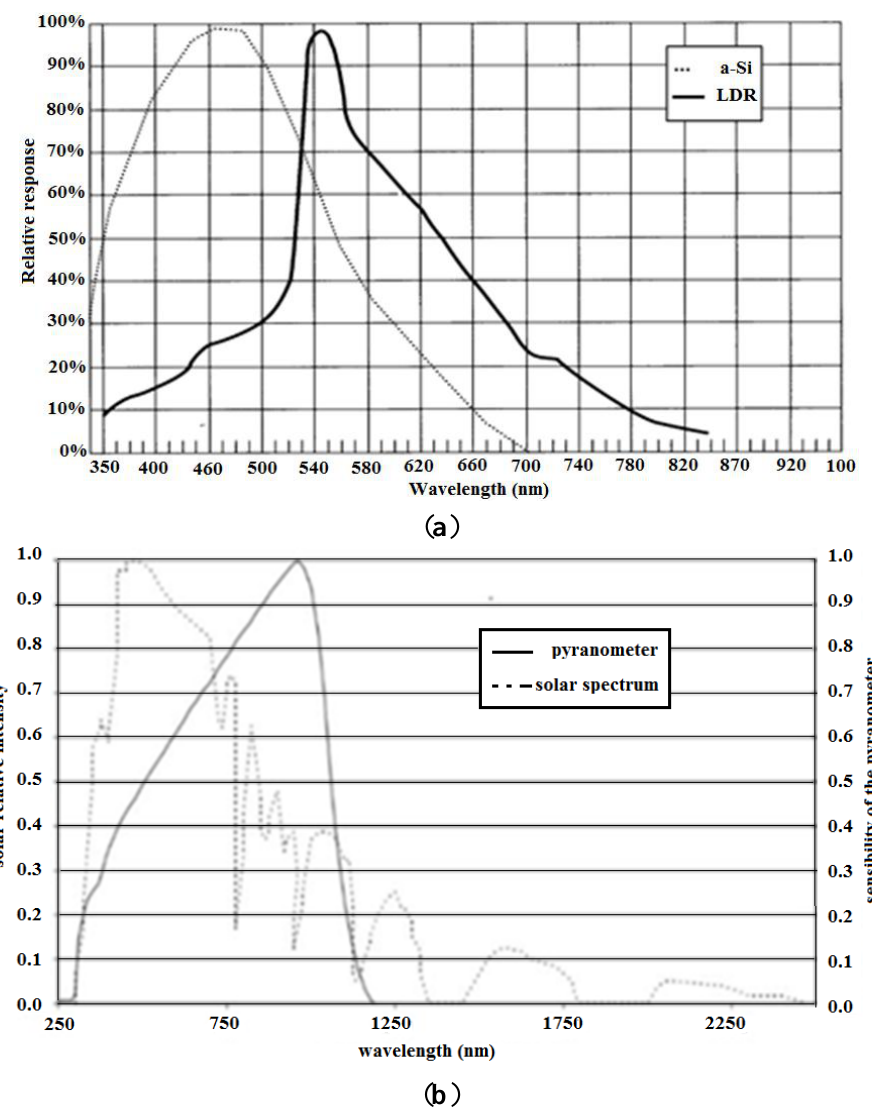
Figure 4. ( a ) The spectral response of amorphous silicon and the LDR ( b ) solar radiation